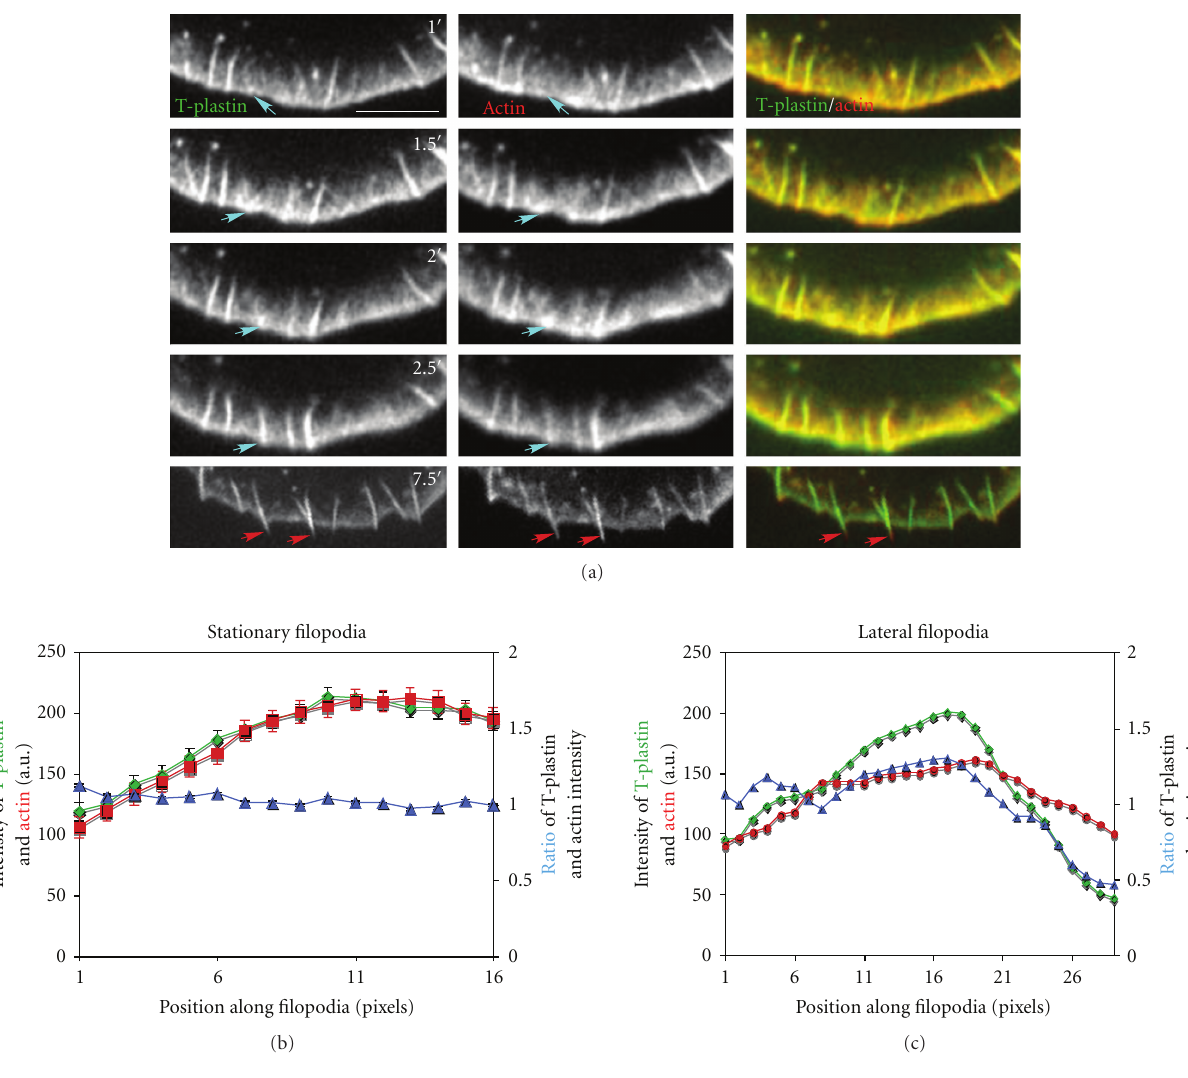
Figure 4: Relative localization of actin and T-plastin to filopodia. (a) Live cell time-lapse of B16F1 mouse melanoma cell co-transfected with GFP-T-plastin and mCherry-actin, showing just the leading edge. Turquoise arrows track a filopodium from initiation of bright dots or short rods, growth of fishtail-shaped filament bundles, and elongatation,. Red arrows indicate lateral filopodia. T-plastin and actin were found throughout stationary filopodia at all stages, but T-plastin was missing from the tips of lateral filopodia. The entire movie can be found in Supplementary Data, Movie 2. (b, c) Quantitative analysis of fluorescence intensity of GFP-T-plastin (green) and mCherry-actin (red) at 1 (cid:3) for stationary filopodia (b) and 7 . 5 (cid:3) for lateral filopodia (c). The x axis represents the distance from the proximal to distal end of the filopodia in pixels. Scale Bar 10 μ